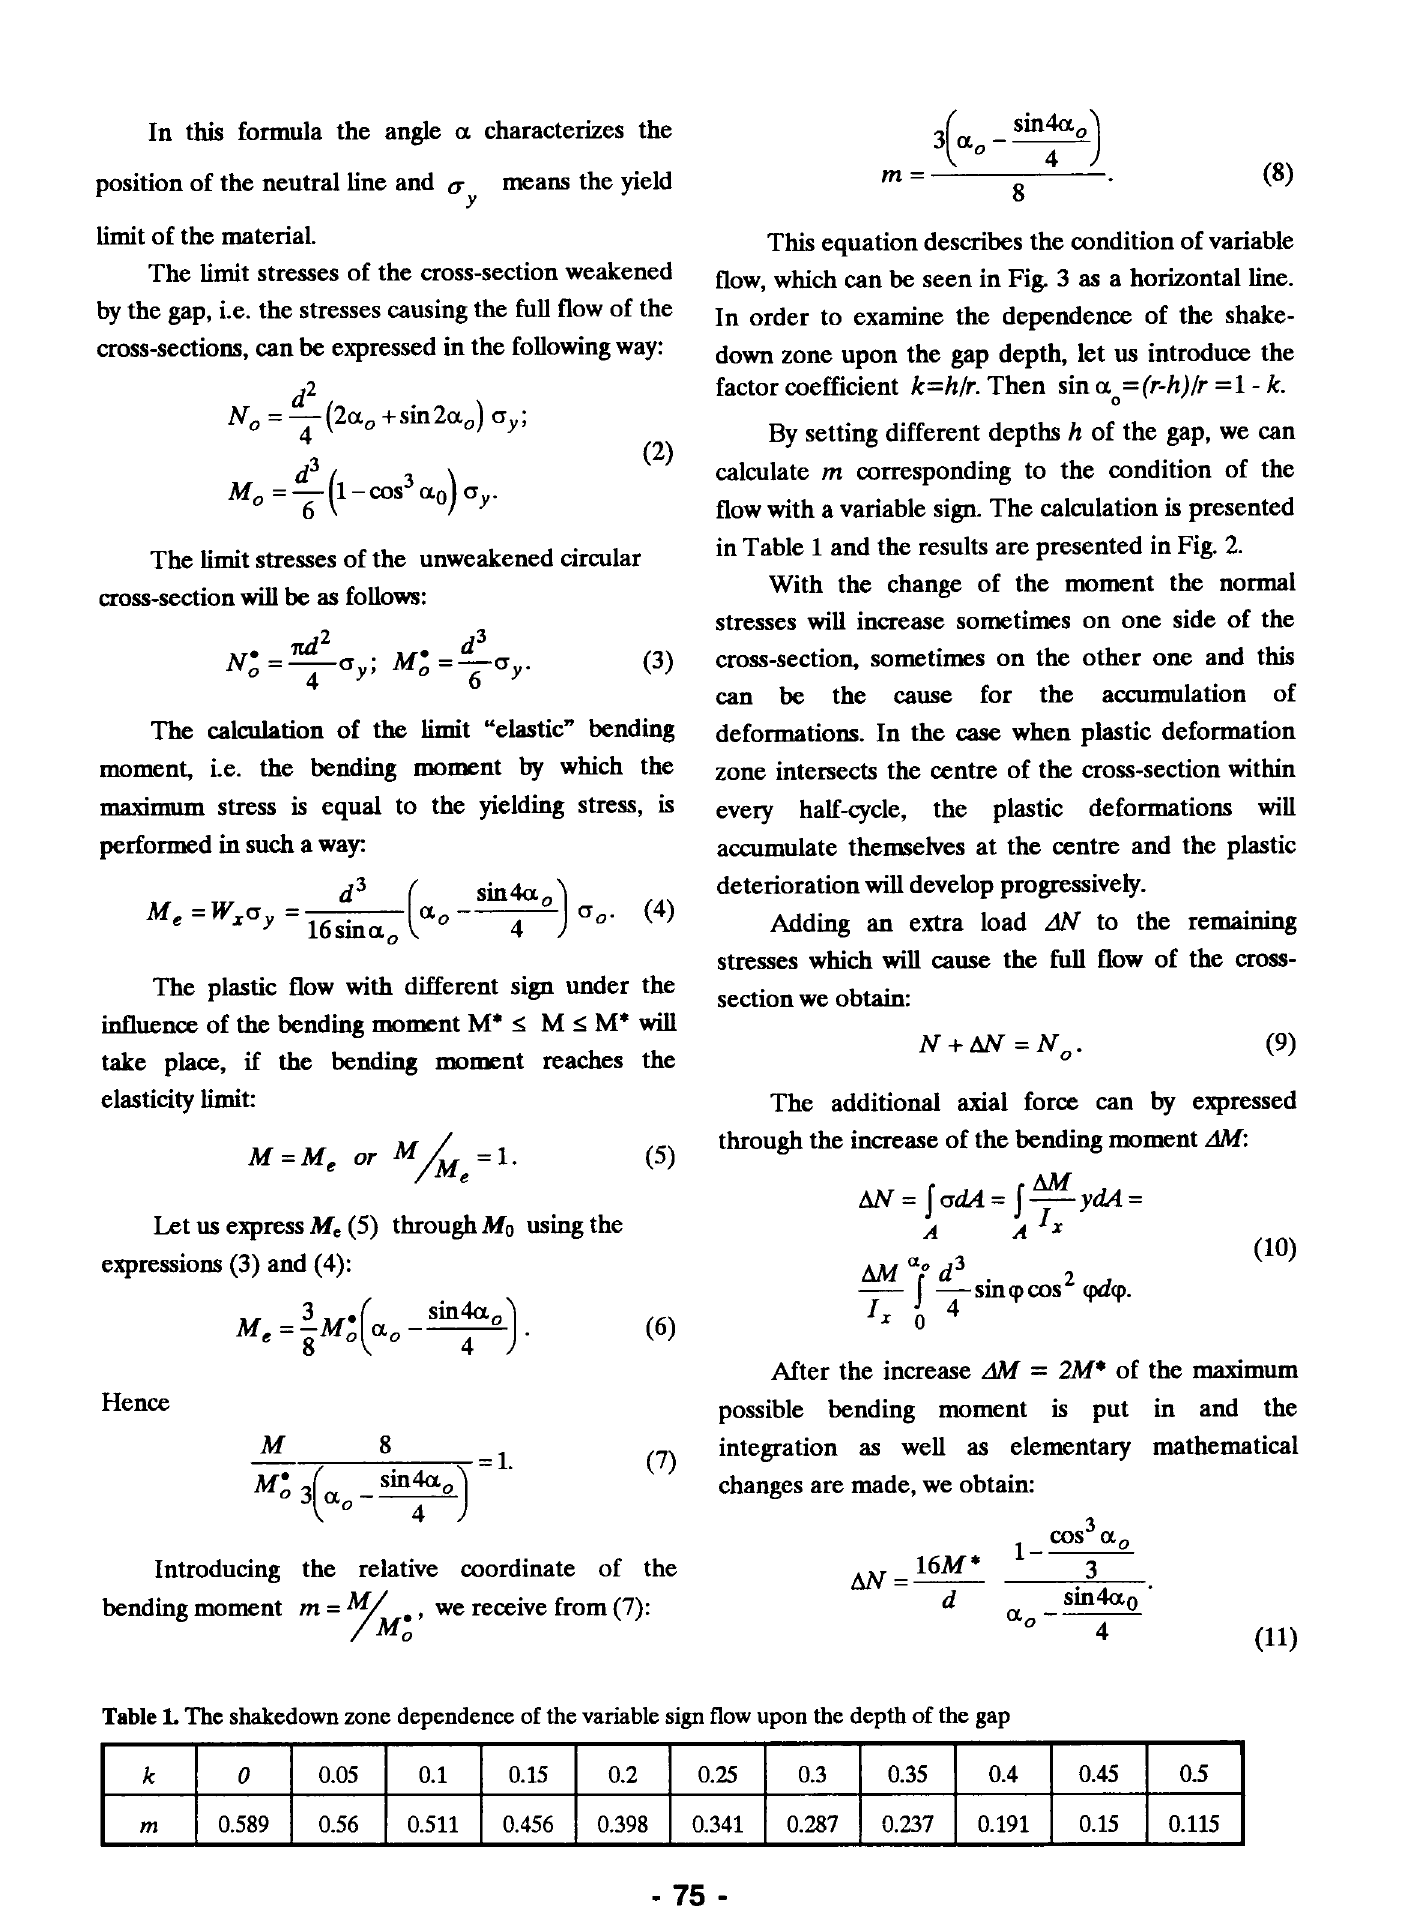
Table L The shakedown zone dependence of the variable sign flow upon the depth of the gap